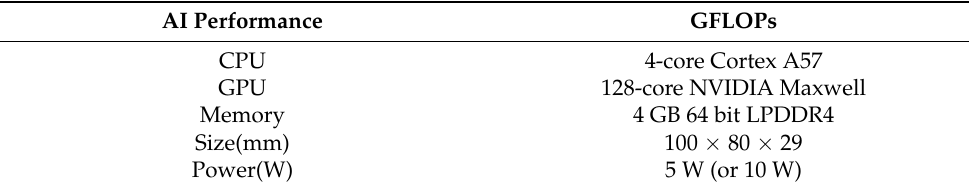
Table 5. Specifications of NVIDIA Jetson Nano.